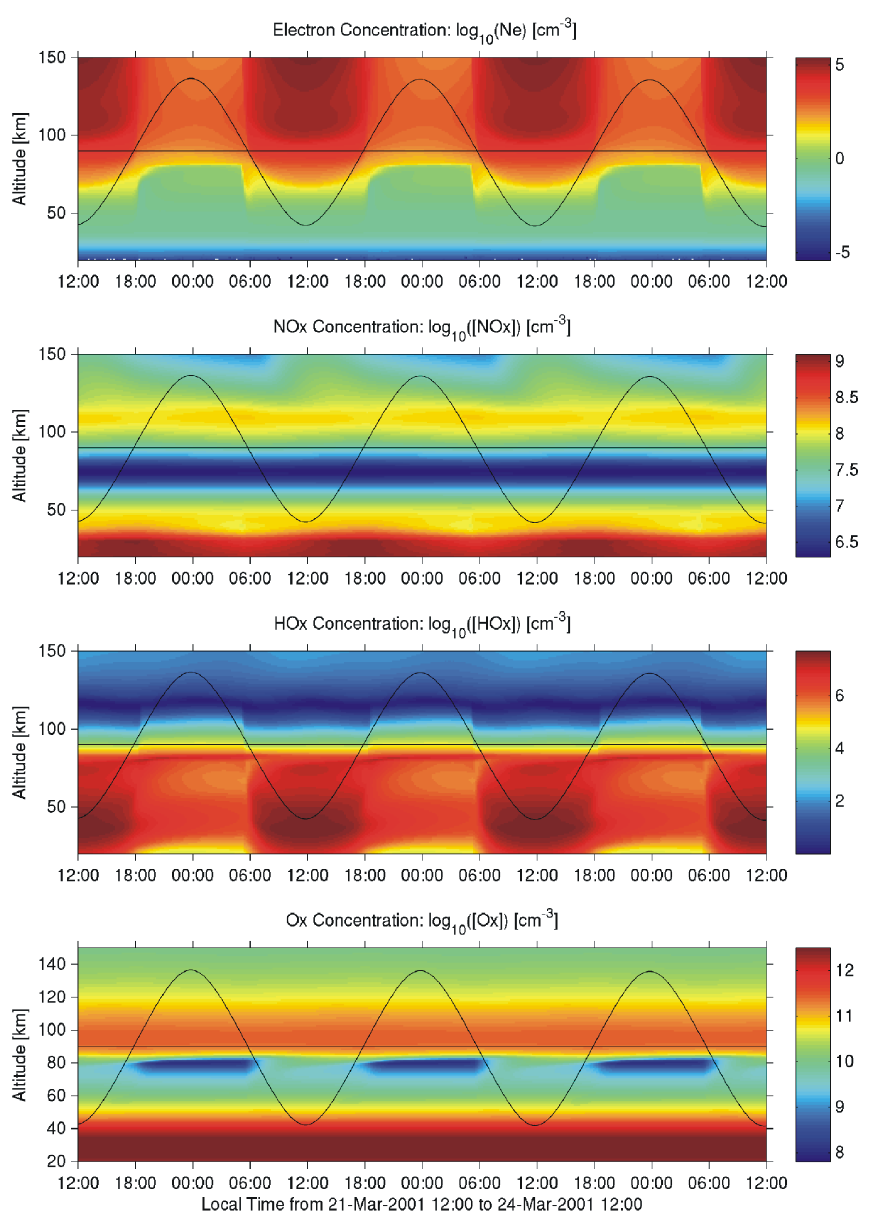
Fig. 6. The results of a SIC modelling run without any RBR-forcing (i.e., zero precipitating electron fluxes), showing the calculated ”normal” conditions. Superimposed is a black curve indicating the solar zenith angle, and hence the diurnal cycle, where local midnight is shown by the highest points in the curve and the dawn/dusk transition by the horizontal black